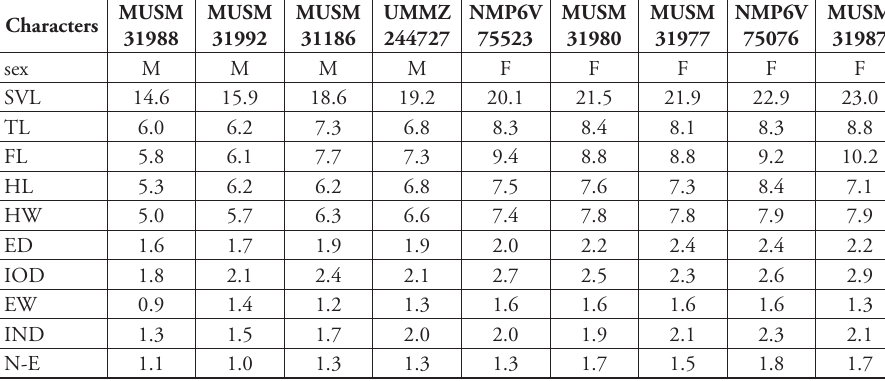
Table 3 . Measurements (in mm) of selected adult type specimens of Pristimantis attenboroughi sp. n. M = male, F = female. For other abbreviations see methods.